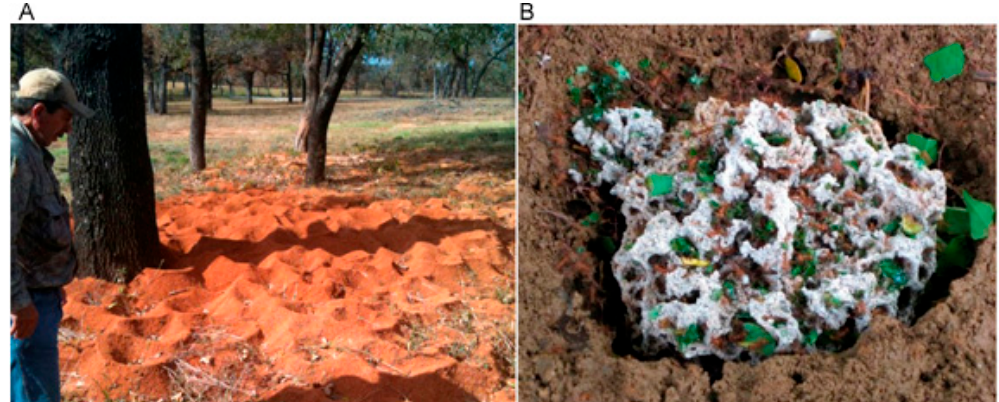
Figure 6. ( A ) Leaf cutter ant colonies in Texas. Photo courtesy of Texas A&M AgriLife Extension/Josh Blanek; ( B ) Leaf cutting ant nest in Costa Rica. In this case the nest was exposed when a rain barrel was moved, normally they are found at greater depth. Photograph courtesy of Herster Barres, Reforest the Tropics .